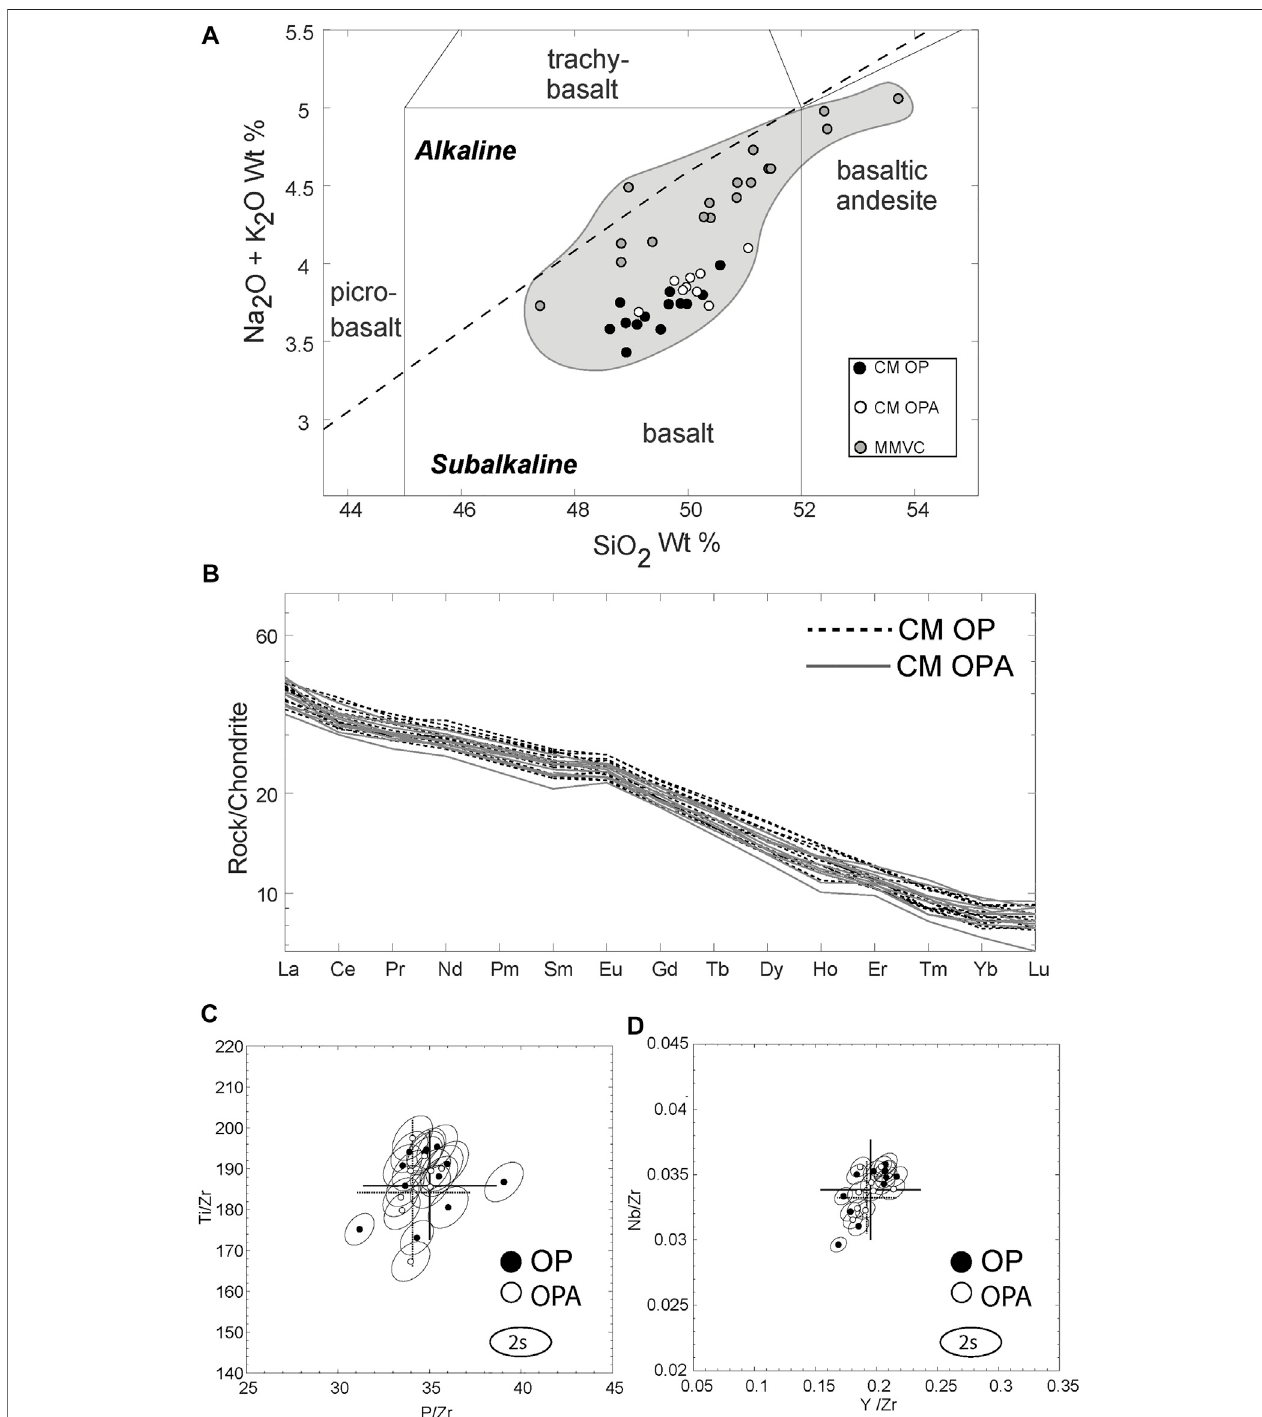
FIGURE 3 | Major and trace element compositions of whole-rock samples from Cracked Mountain. OP samples are in black, OPA samples are shown in white. Reference MMVC ma fi c data is shown in grey (Harris and Russell, 2021). (A) Total alkali (Na 2 O + K 2 O) vs. Silica (SiO 2 ) wt% (TAS) with the classi fi cation of Le Bas et al. (1986), Irvine and Baragar (1971). (B) Rare Earth Trace Element (REE) compositions of Cracked Mountain volcanic deposits, normalized to a Chondrite after Sun and McDonough (1989). (C) Incompatible element ratios (Ti/Zr vs. P/Zr) showing no signi fi cant variation between two phenocryst suites (i.e., OP and OPA). Ellipses denote2 σ uncertaintyforeachdatapoint.Alsoshownisthe2-standard-deviationonthemeanforeachsuite(dashedandsolidbarsrespectively). (D) Traceincompatible element ratios (Nb/Zr vs. Y/Zr) showing no signi fi cant variation between two phenocryst suites (i.e., OP and OPA). Same symbology as in 3C.